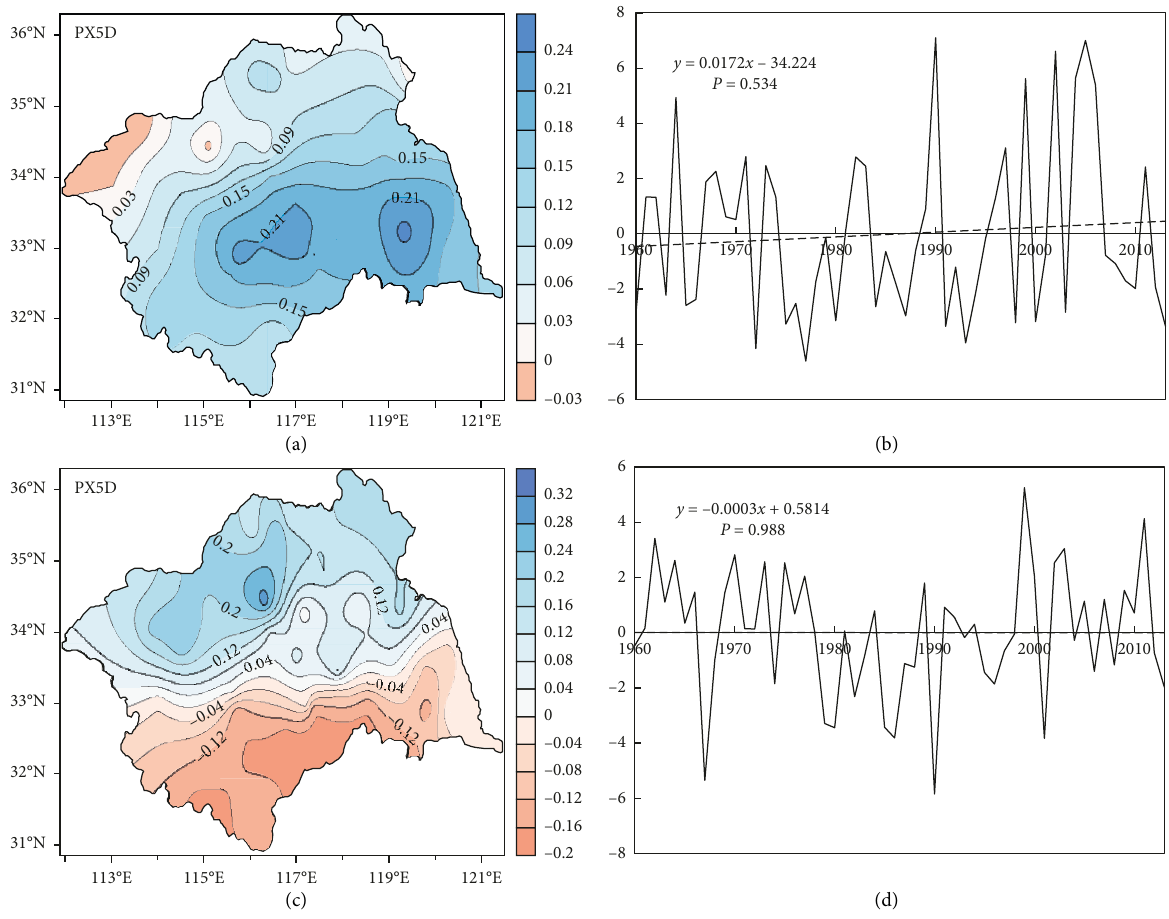
Figure 5: EOF results of PX5D in HRB. (a) EOF1. (b) PC1. (c) EOF2. (d)